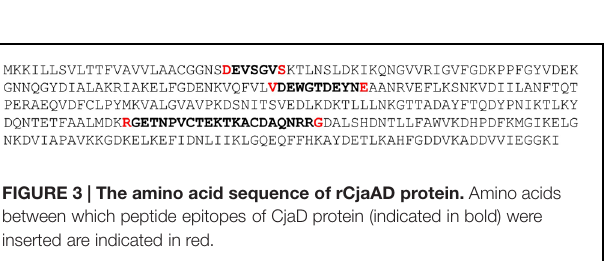
FIGURE 3 | The amino acid sequence of rCjaAD protein. Amino acids between which peptide epitopes of CjaD protein (indicated in bold) were inserted are indicated in